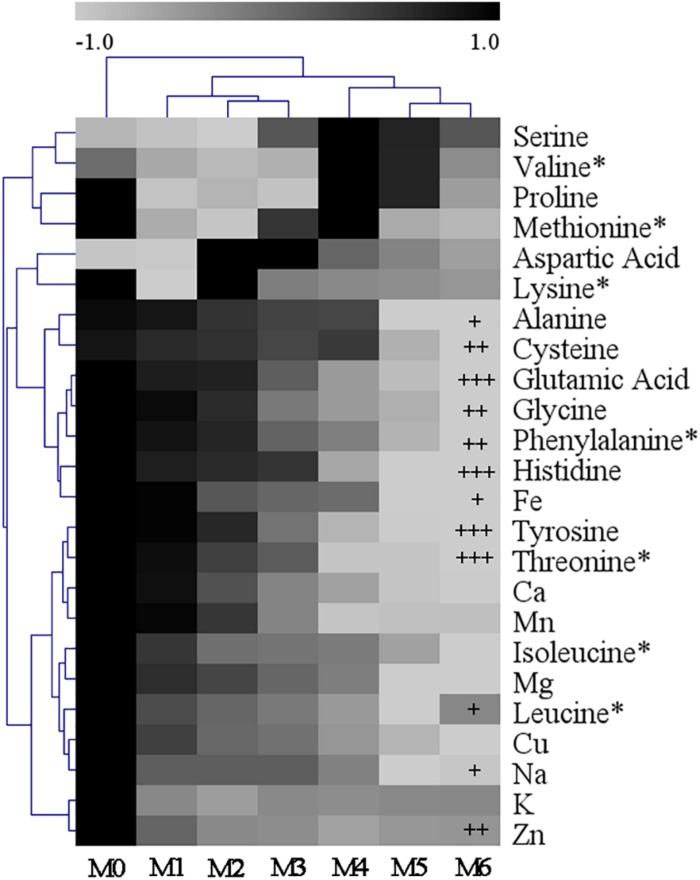
Heatmap showing the normalized content values of amino acids and mineral elements among the different V. volvacea strains. The normalized content values are depicted visually from black to gray; black represents the greatest value and gray the lowest value. The dendrogram distances represent the amino acids and mineral elements (left) based on their content values in the strains (top). T-tests were used to identify the differences between M0 and M6. +: P < 0.05; ++: P < 0.01; and +++: P < 0.001. ∗: essential amino acid.